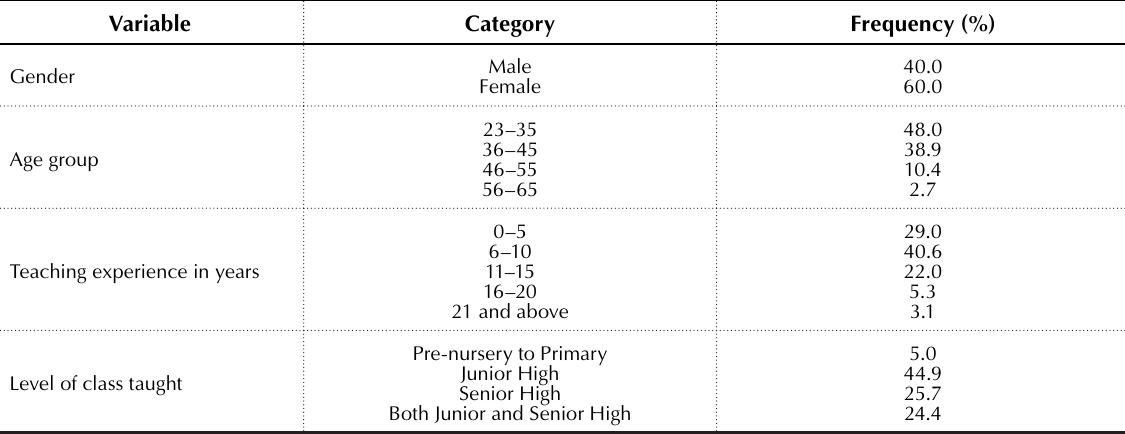
Table 2. Profile of the respondents (n =